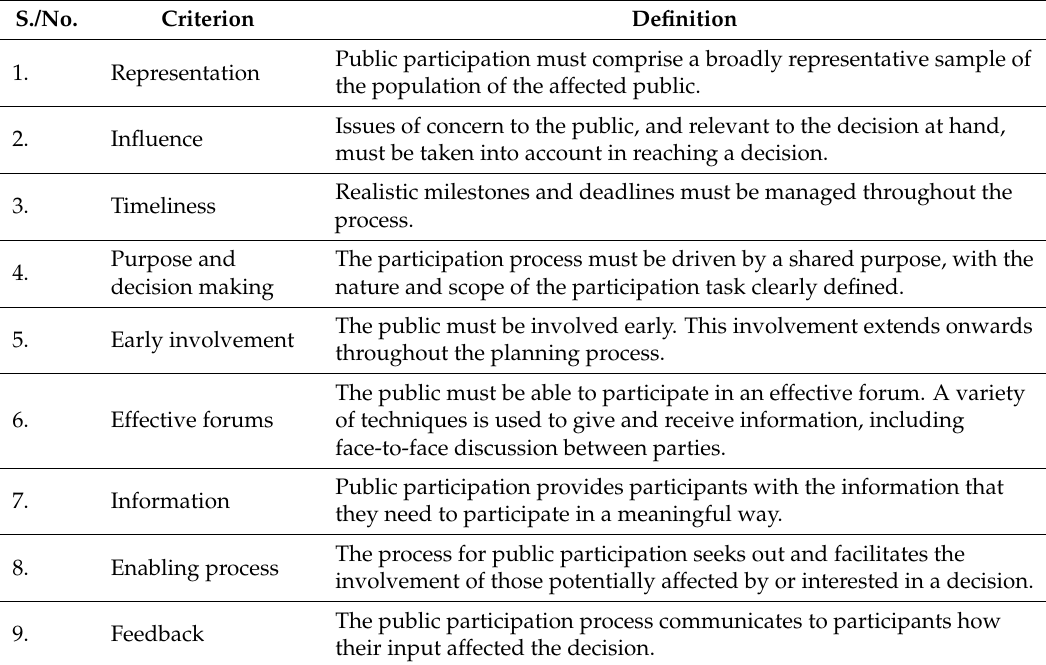
Table 1. Evaluation Criteria for public participation